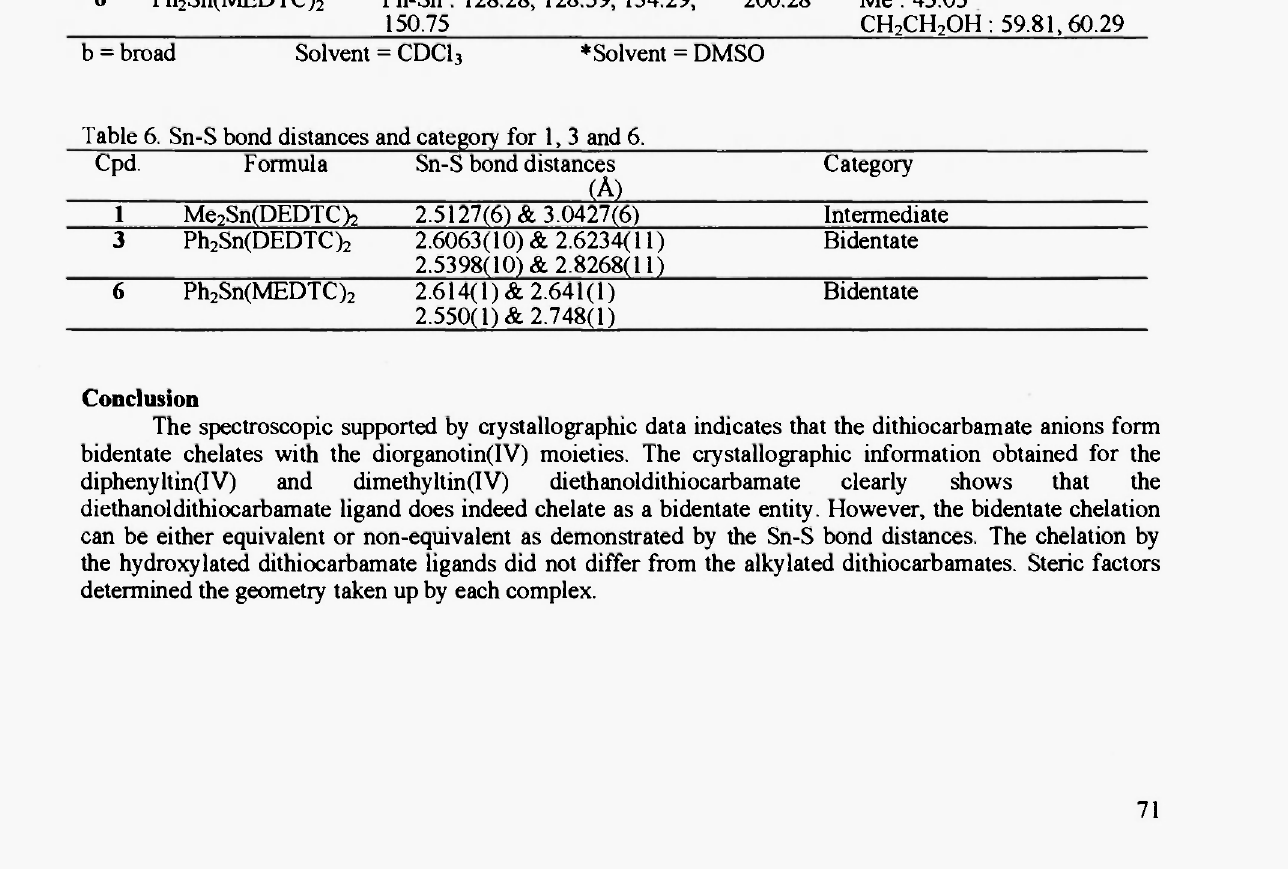
Table 5. Important 13 G NMR spectral data. Cpd.